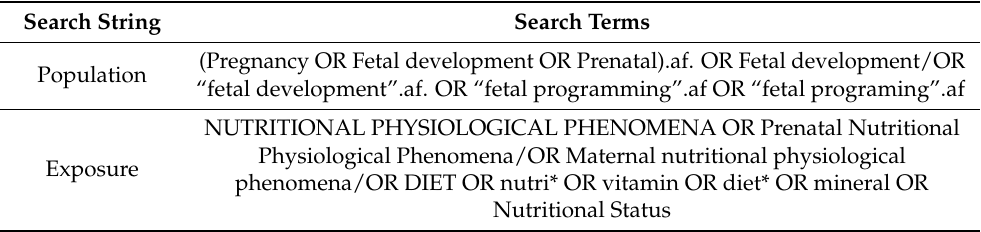
Table 1. Search strategy for MEDLINE (OVID). Search String Search